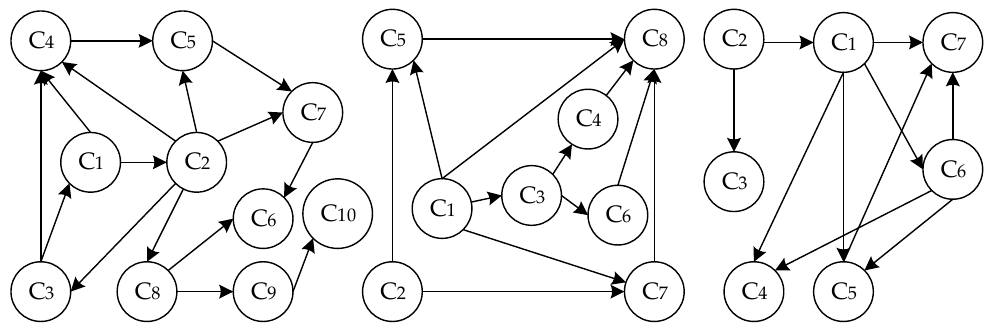
Figure 14. Some existing node conflict networks.